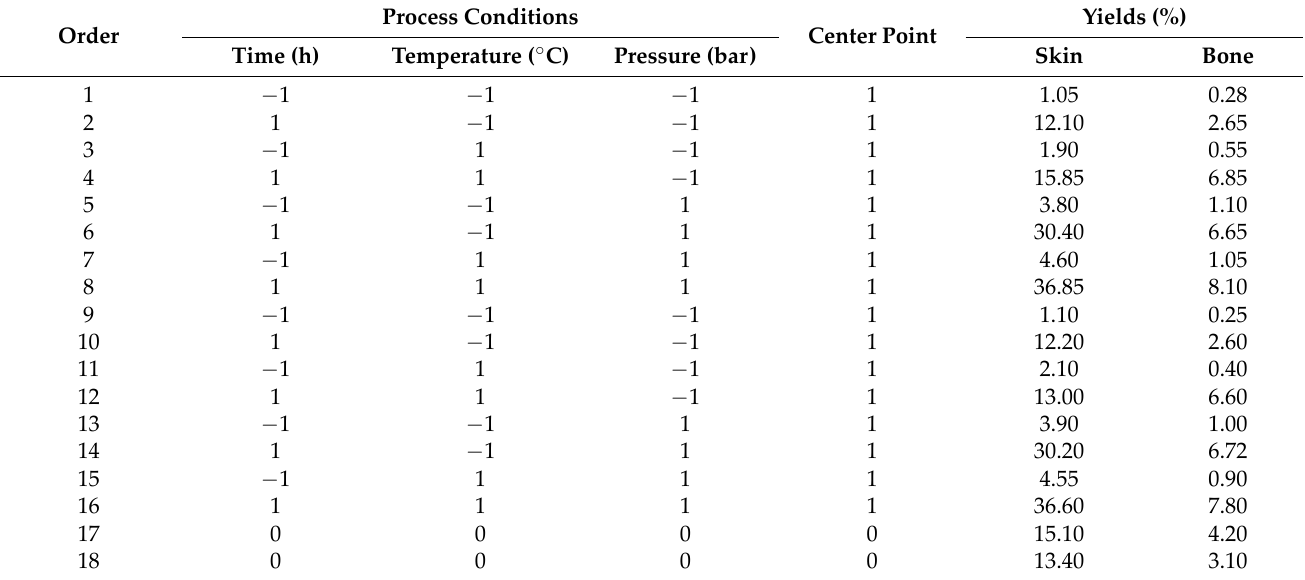
Table 1. The 2 k factorial design and the responses of collagen/gelatin from the skin and bone of striped